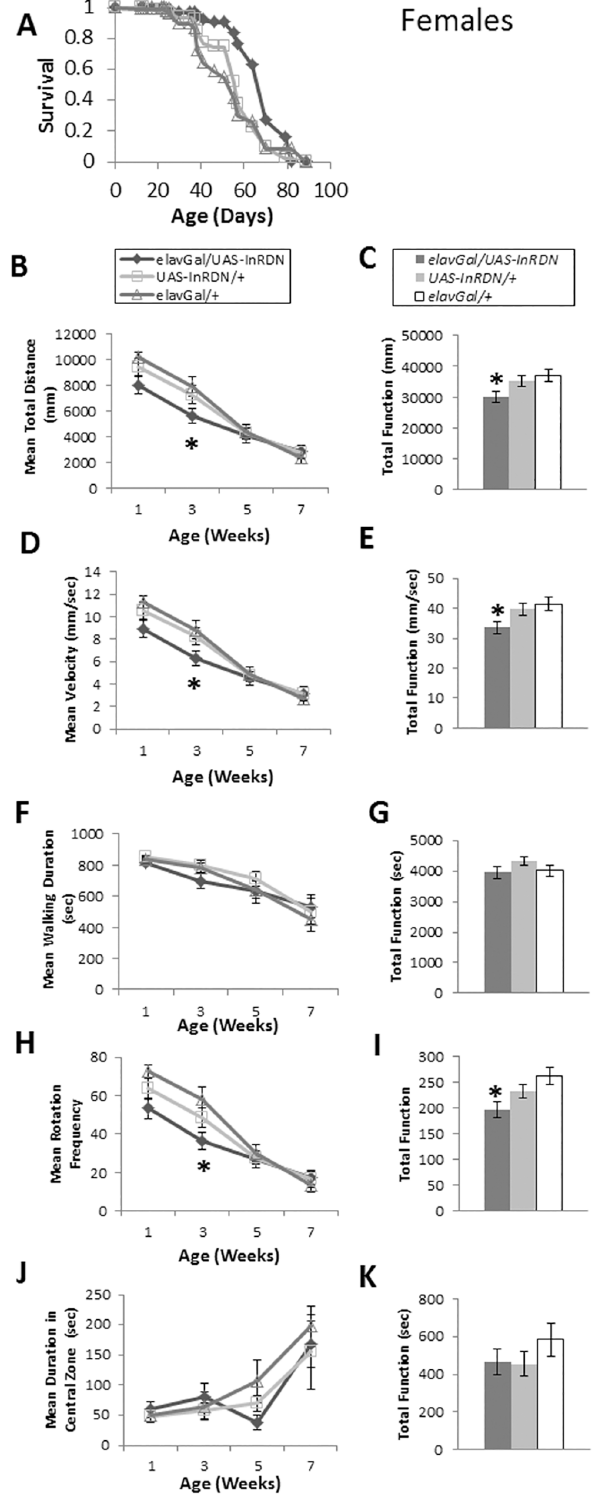
Fig 4. Exploratory walking senescence in elavGAL4/UAS-InR DN female flies. (A) Survival of elavGAL4/ UAS-InR DN once mated female flies compared to elavGAL4/+ and UAS-InR DN /+ controls. Survival curves were compared using nonparametric log rank tests and p values calculated. Median lifespans and sample